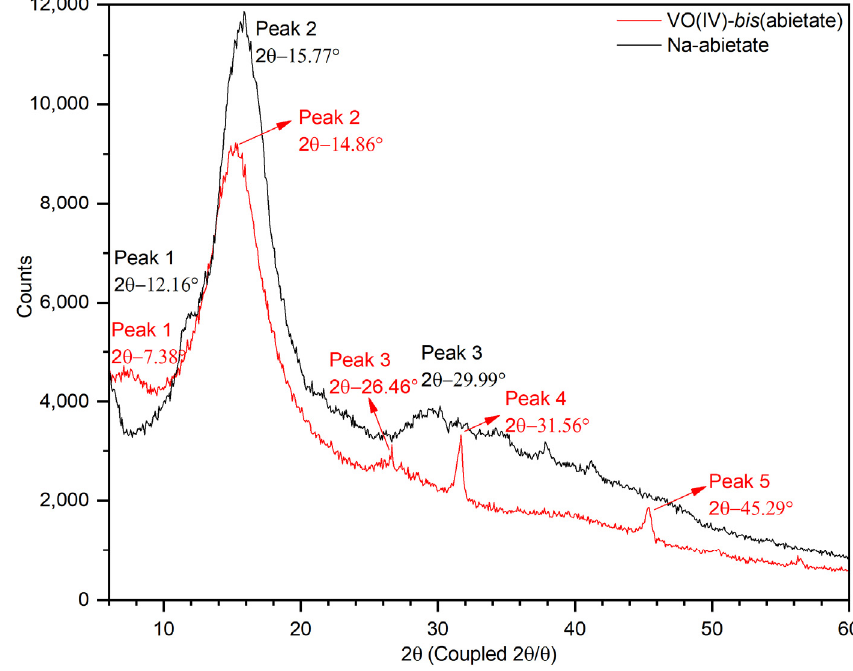
Figure 5. XRD profiles for the Na-abietate and VO(IV)- bis (abietate) samples. In the XRDP for Na-abietate, three characteristic peaks were identified at 2 θ 12.16 ◦ (d = 7.27 Å), at 2 θ 15.77 ◦ (d = 5.62 Å), and at 2 θ 29.99 ◦ (d = 2.98 Å). For the VO(IV)- bis (abietate), five diffraction peaks are highlighted at 2 θ 7.38 ◦ (d = 11.97 Å), at 2 θ 14.86 ◦ (d = 5.95 Å), at 2 θ 26.46 ◦ (d = 3.37 Å), in 2 θ 31.56 ◦ (d = 2.83 Å), and in 2 θ 45.29 ◦ (d = 2.00